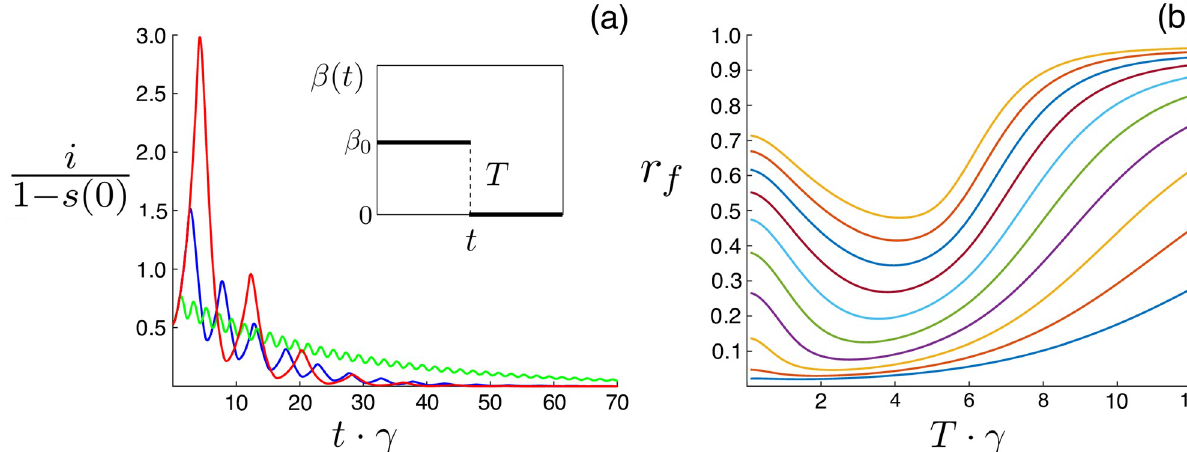
Fig 1. Periodic closure examples. (a) fraction infectious, normalized by initial conditions, versus time for T = 10 � days (green), T = 25 � days (blue), T = 40 � days (red) closure periods. The inlet panel shows a schematic of β ( t ). Other model parameters are: γ − 1 = 10 � days, α − 1 = 8.33 � days, and b (cid:0) 1 ¼ 5 � days . (b) Outbreak size versus the closure period. Curves correspond to different R 0 = β 0 / γ , starting from the bottom: first ( R 0 = 1.5), second 0 ( R 0 = 1.7), ... , top ( R 0 = 3.3). Other model parameters are identical to